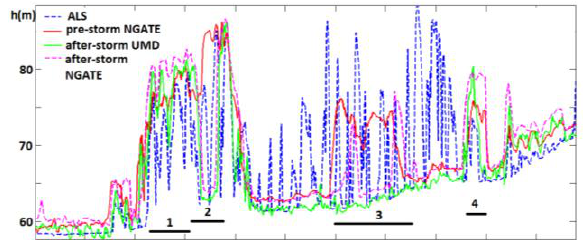
Figure 4. Example of surface height profiles in the area of Figures 2 and 3. An intact area in forest is marked with 1. In the area marked with 2, the pre-storm NGATE surface is high and the others low, this could be a place where windfall has occurred. In the area marked with 3, thinning has probably taken place between the ALS and the pre-storm NGATE, and the storm has finished most of the trees that were left after thinning. The area marked with 4 shows how the UMD surface forms steeper edges than the NGATE surface.